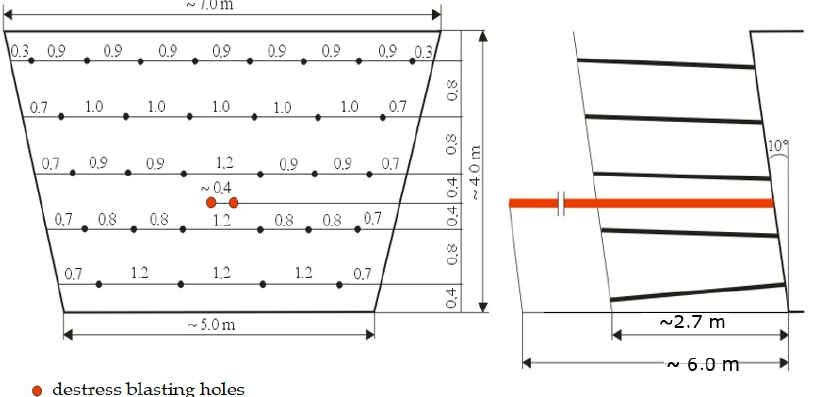
Figure 17. Arrangement of blasting holes in the ore forehead.